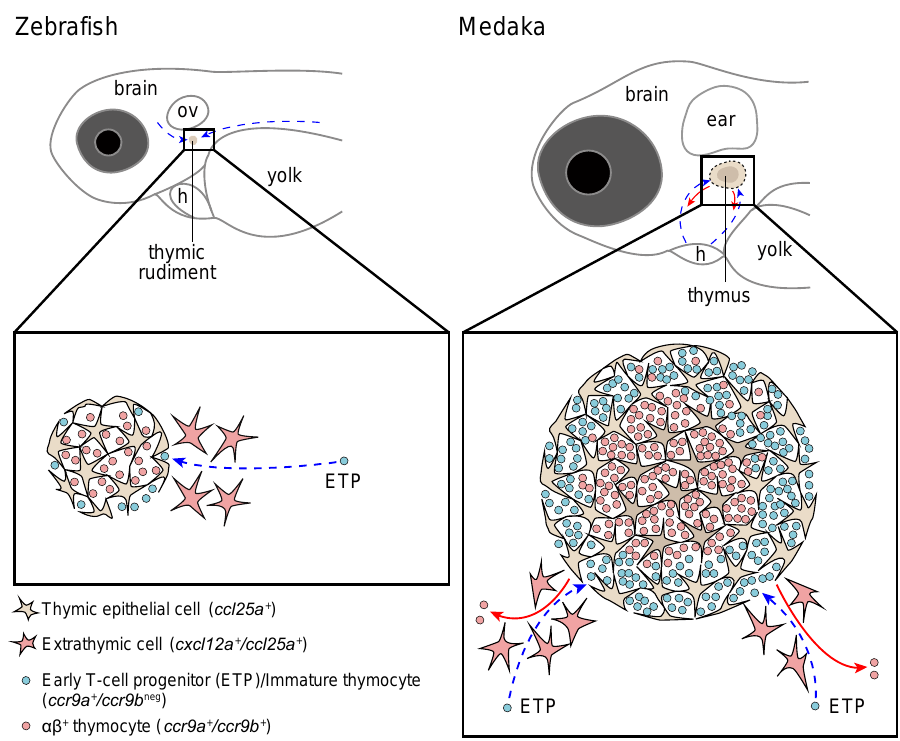
Figure 3. Early colonization of the thymus by lymphoid progenitors in freshly hatched zebrafish and medaka larvae. A schematic illustration of the migratory paths of thymus colonization in zebrafish (left panel) and medaka (right panel) at the time when they hatch out of the chorion according to previous studies [30,31,42,48]. Blue dashed arrows indicate the migration path of cells from the extrathymic mesenchyme into the thymus. Red arrows indicate the migratory pathways of RTEs into the periphery. Abbreviations: h, heart; ov, otic vesicle.